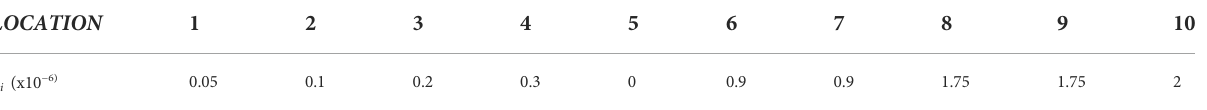
TABLE 1 Values of the optimal shunting inductances.